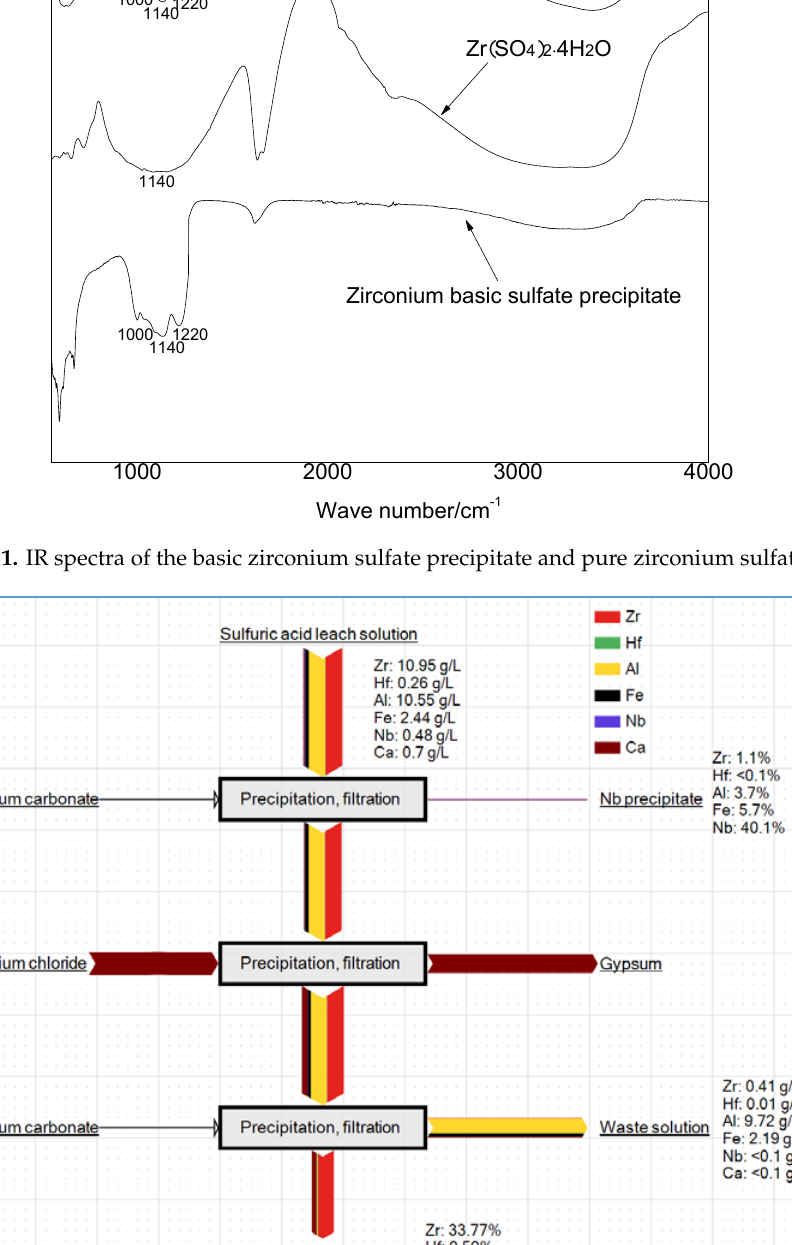
Figure 12. Proposed flowchart for the recovery of Zr, Hf, and Nb from the sulfuric acid leach solution using selective precipitation.